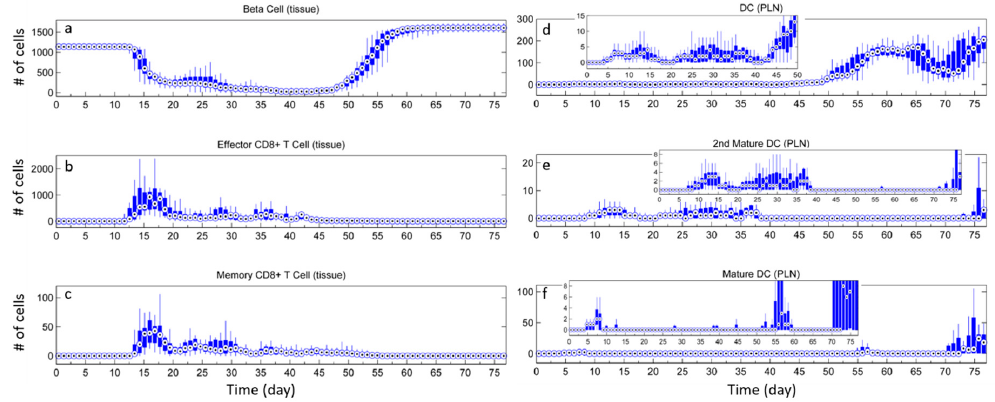
Figure 8. Simulation results for case with Tregs intervention (case VI). There are no initial Tregs and also no conversion ability of CD4 + T cells. Tregs were added at 8th week. The number of ( a ) β cells, ( b ) effector CD8 + T cells, ( c ) memory CD8 + T cells- in pancreatic tissue are shown on the left column. The number of ( d ) total DCs, ( e ) 2nd mature DCs, ( f ) mature DCs in PLN are shown on the right column. Inserts (number of cells vs. time) show small change of cell number in the bottom figures. t = 0 days correspond to 3-week age of mouse.